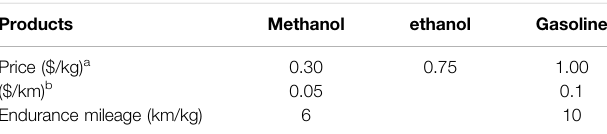
TABLE 1 | Comparison of oil